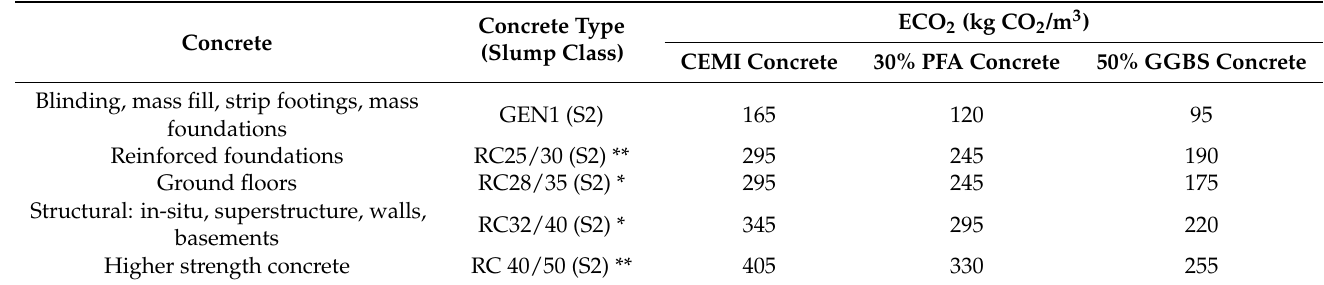
Table 3. Effect of Cement type on ECO 2 content of designated concretes [45].